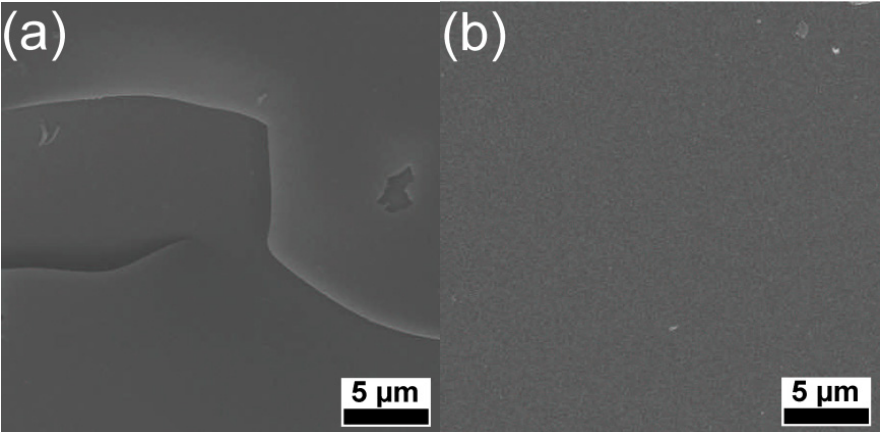
Figure 1. Scanning Electron Microscopy (SEM) micrographs of carbon thin films deposited in vacuum at ( a ) room-temperature and ( b ) 200 °C, on bare quartz substrates.